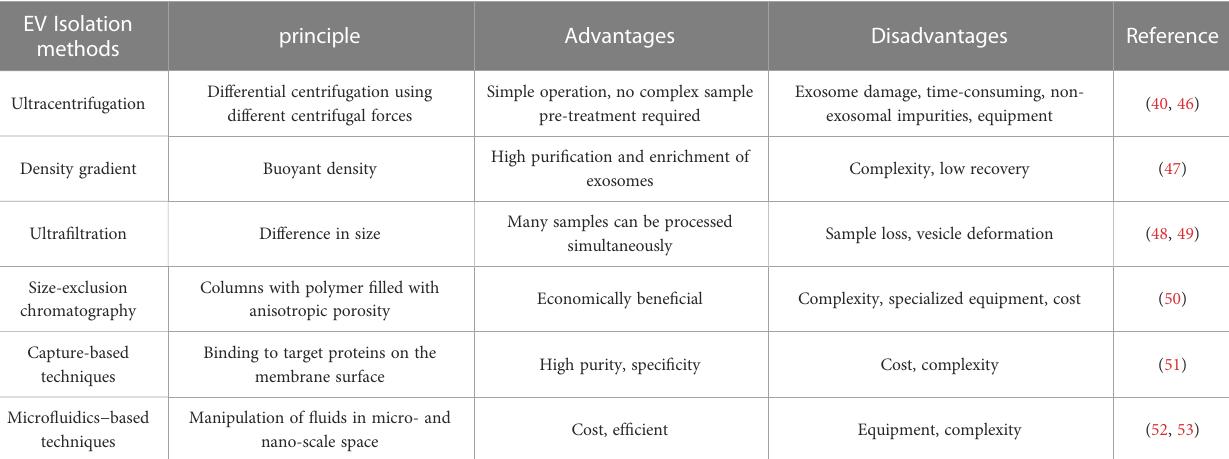
TABLE 1 Isolation method of